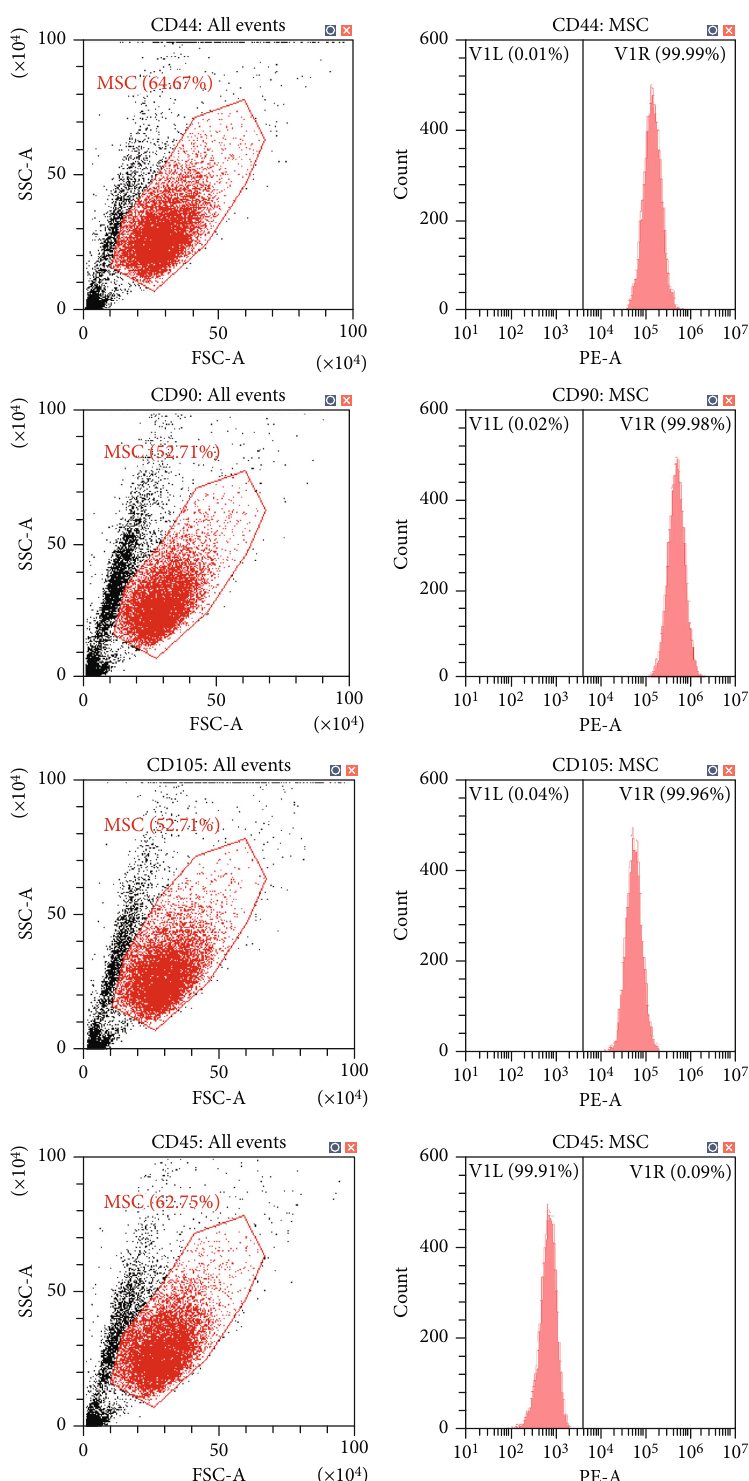
Figure 2: The surface markers of IPFP-MSCs isolated from three rabbits characterized by fl ow cytometry in passage 3: no expression of CD45 and strong expression of CD44, CD90, and